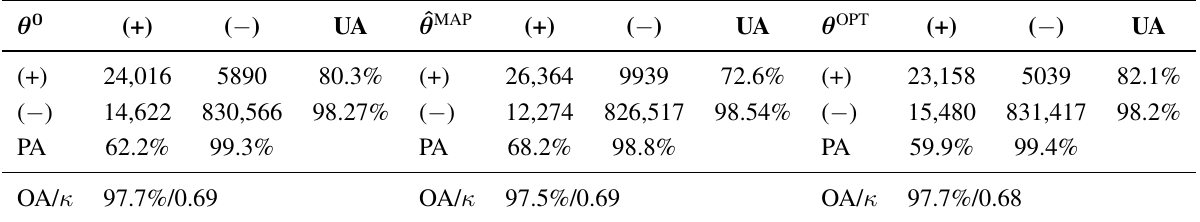
Table 5. Confusion matrices and accuracy measures for the class barley realized with the manually selected model (see Figure 5e) given the threshold θ 0 obtained by the BSVM (left), ˆ θ MAP obtained by Bayes’ rule (middle), and the optimal threshold θ OPT